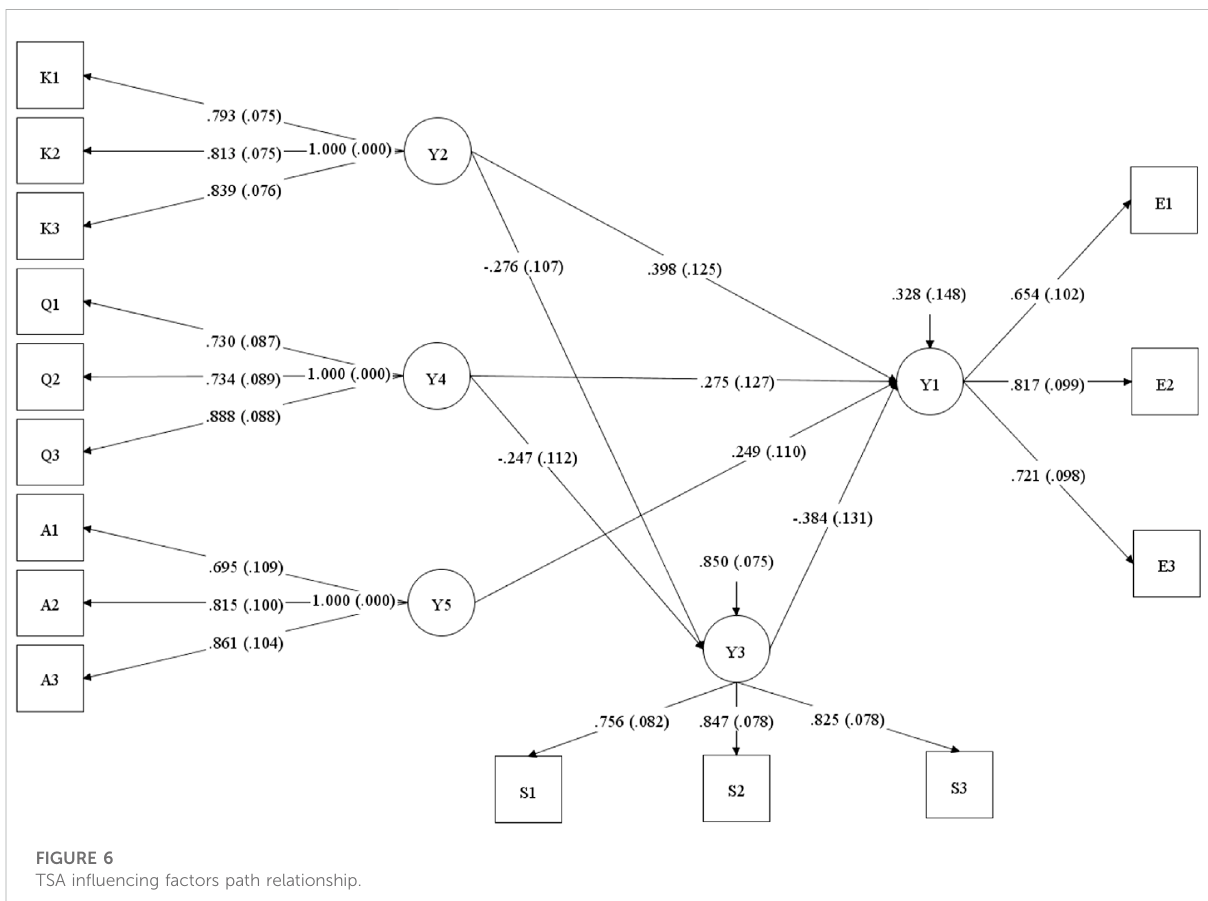
FIGURE 6 TSA in fl uencing factors path relationship.